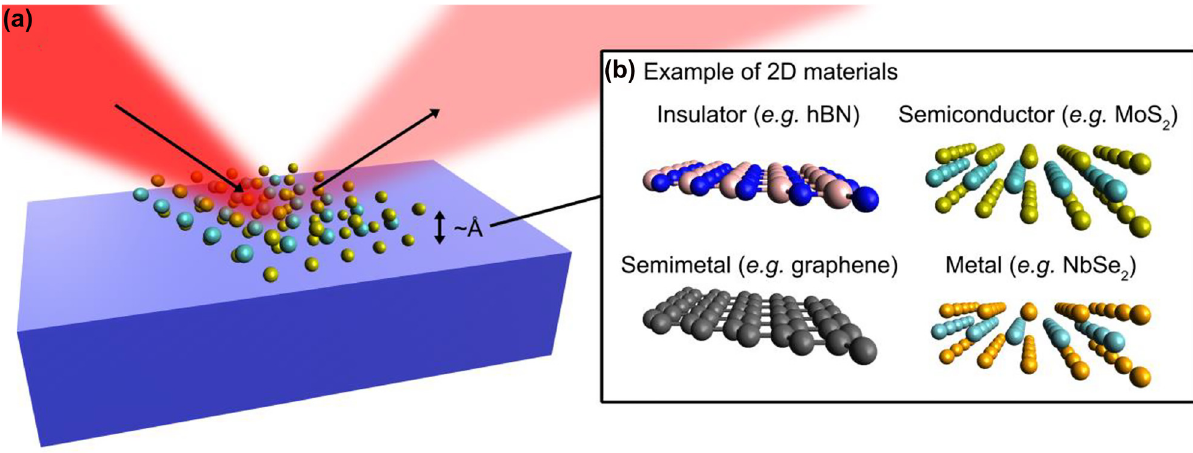
Figure 1: Spectroscopic ellipsomety for low-dimensional materials. (a)Spectroscopicellipsometrymeasuresamplitudeandphaseofthelightobliquelyreflectedby2Dmaterialsonasubstrate.Thicknessof the 2D materials is usually at the Angstrom scale. (b) Typical 2D materials with various optical, electrical, and magnetic